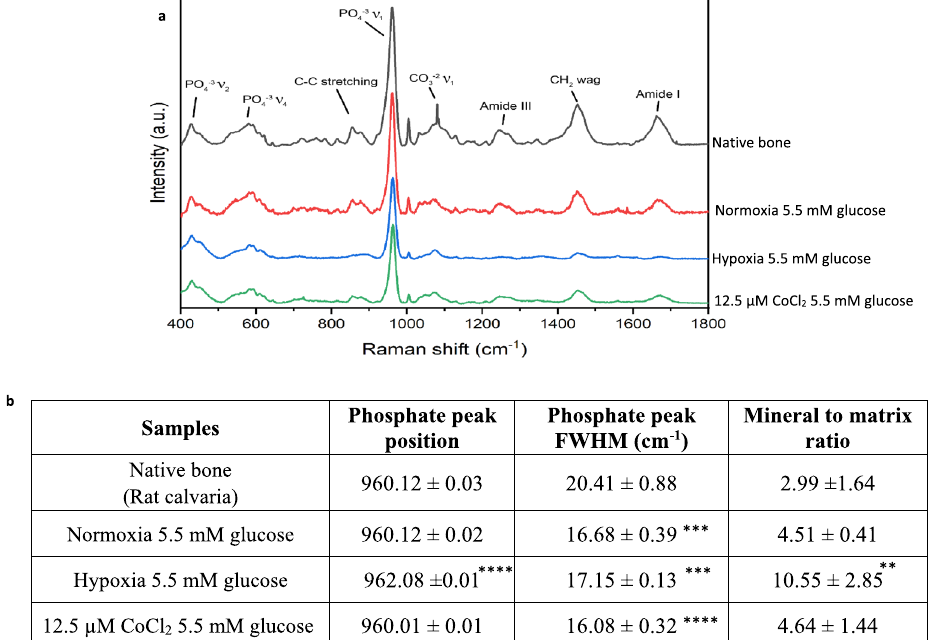
Figure 6. Raman spectra of rat calvarial native bone and rat calvarial osteoblasts in normoxia, hypoxia and 12.5 µM CoCl 2 all in normal glucose conditions (5.5 mM). ( a ) Average Raman peaks associated with proteins (Amide III, CH 2 , Amide I) are much reduced in hypoxia compared to normoxia, ( b ) with a much higher mineral to matrix ratio. The hypoxia mimetic CoCl 2 had a different effect than hypoxia and had a biochemical composition more similar to normal culture conditions and bone. **P ≤ 0.01; ***P ≤ 0.001*; ****P ≤ 0.0001 (the minimum number of bone nodules per treatment =